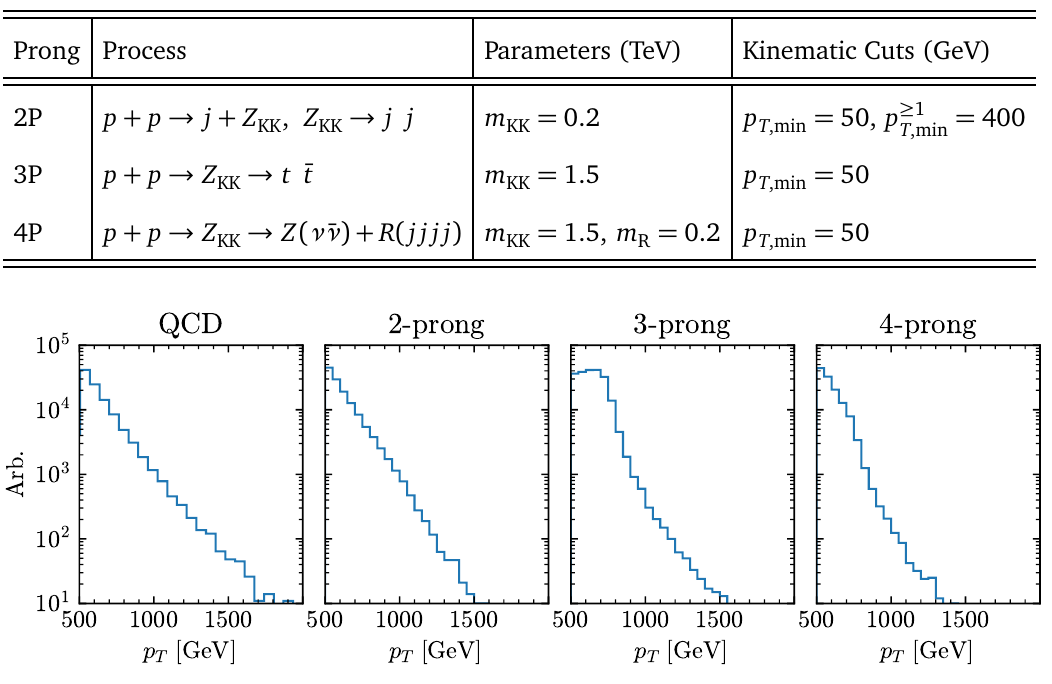
Table 1: Details of the signal process used in the event generation, along with the choice of parameters and generation level kinematic cuts.